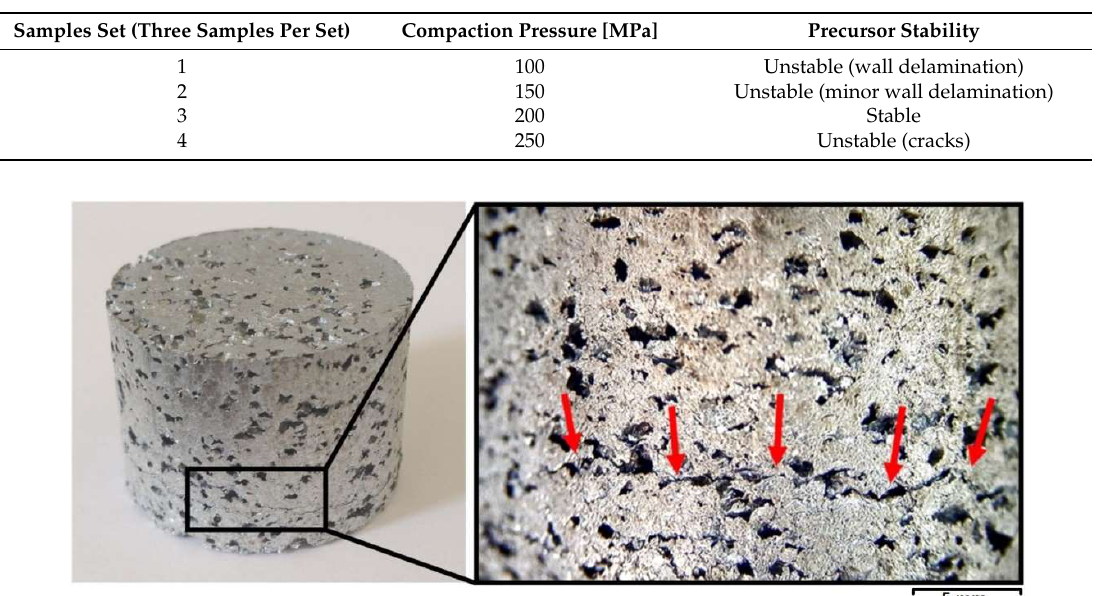
Table 1. Table of compaction experiments.